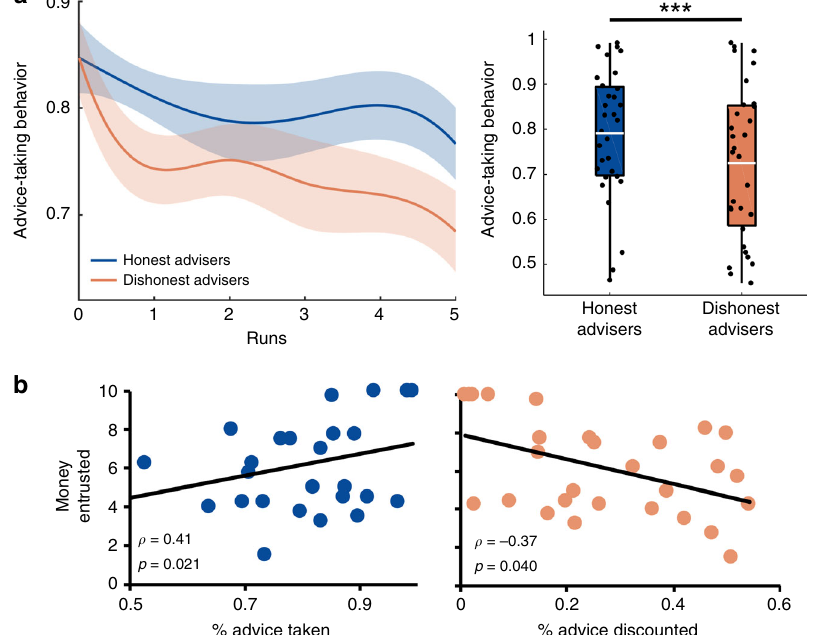
Fig. 2 Behavioral results. a Trusting behavior in the take advice game over runs (left) and on average (right) toward honest and dishonest advisers. On average, participants took signi fi cantly more advice from the honest than the dishonest adviser ( t test). Data points on the left were interpolated for visualization purposes and shadowed areas represent standard errors. White lines in the box-plots on the right represent average advice-taking behavior across participants. Each black dot represents one participant. b Amount of money entrusted in the trust game with honest (left) and dishonest (right) others correlated with participants ’ willingness to take advice from the advisers (Spearman ’ s correlations). Each dot represents one participant. *** P <